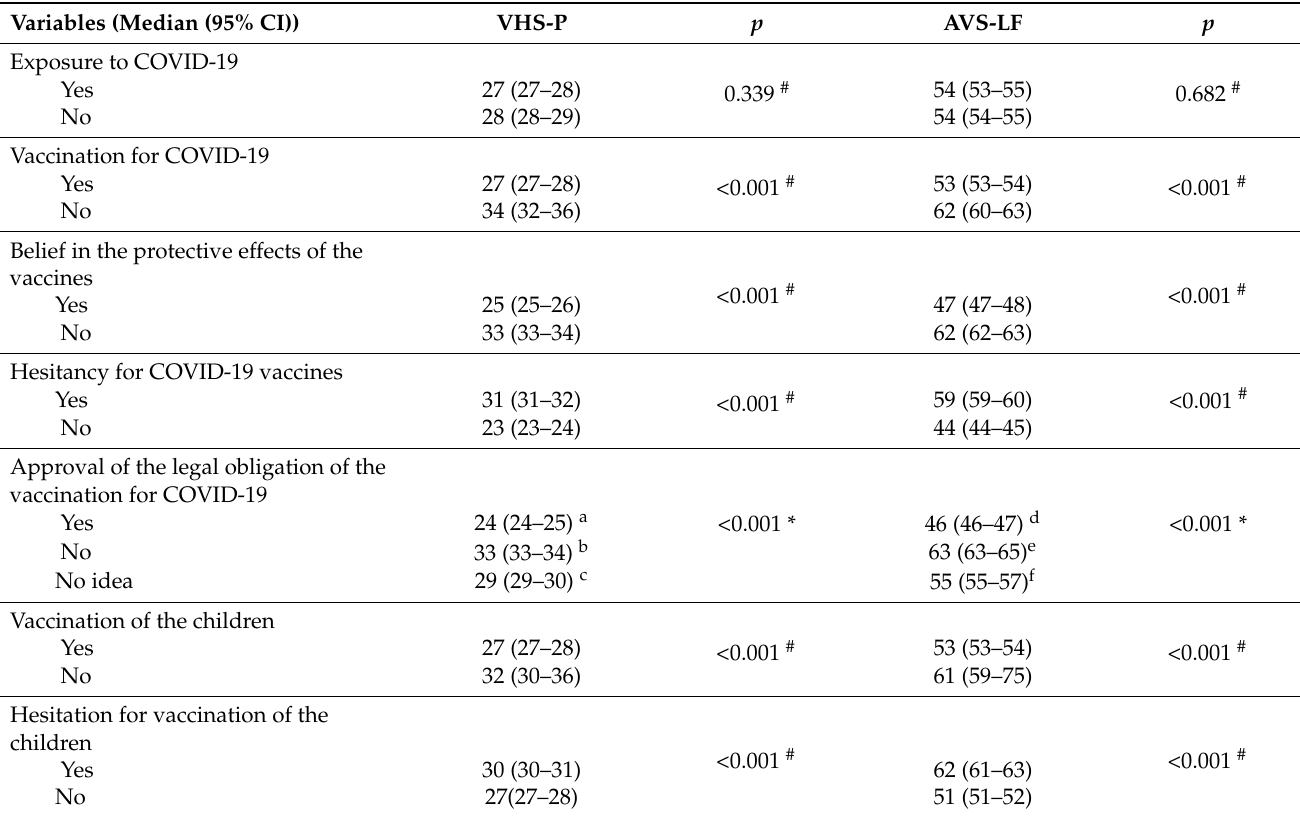
Table 5. Comparison of VHS-P and AVS-LF scales according to COVID-19 and vaccination